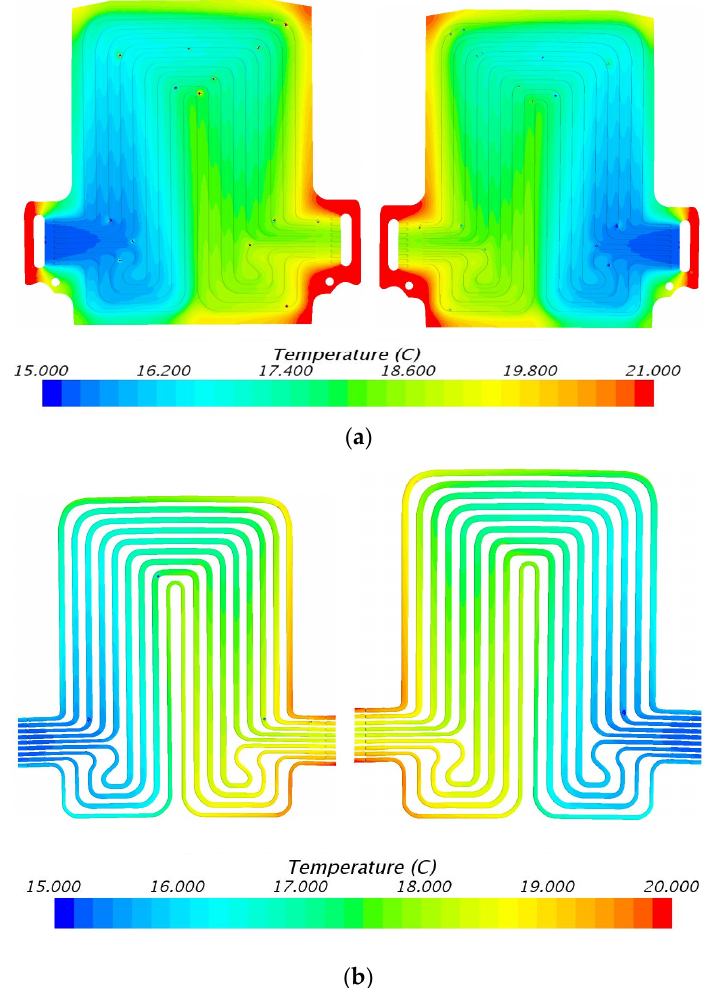
Figure 8. Temperature profile at 60 A and 15 ◦ C with heat flux values near cathode = 1711.8 W / m 2 , anode = 2351.6 W / m 2 , and mid surface = 548.4 W / m 2 . ( a ) Top view and ( b ) bottom view.